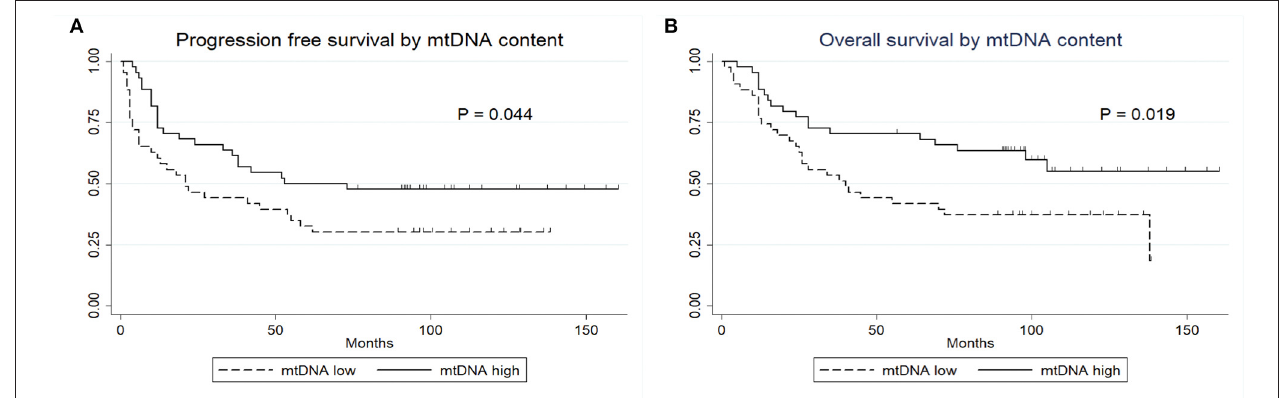
FIGURE 2 | Kaplan-Meier survival curves. (A) PFS of patients by mtDNA content. (B) OS of patients by mtDNA content.